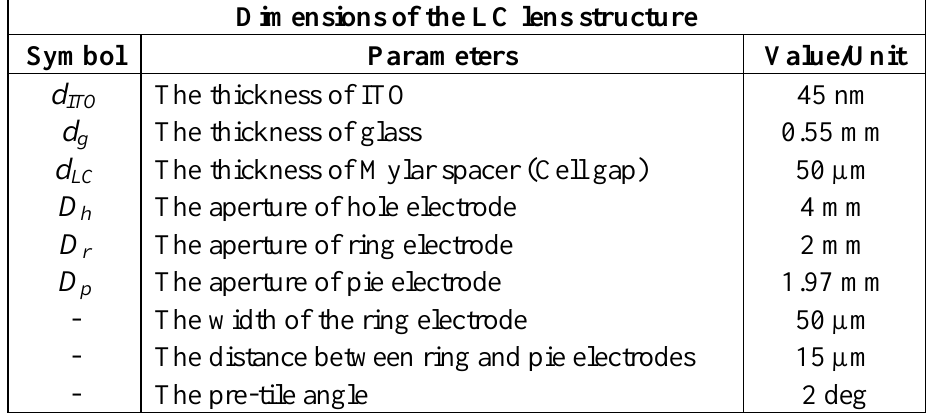
Table 1. The parameters and structure specifications of the proposed DFLC